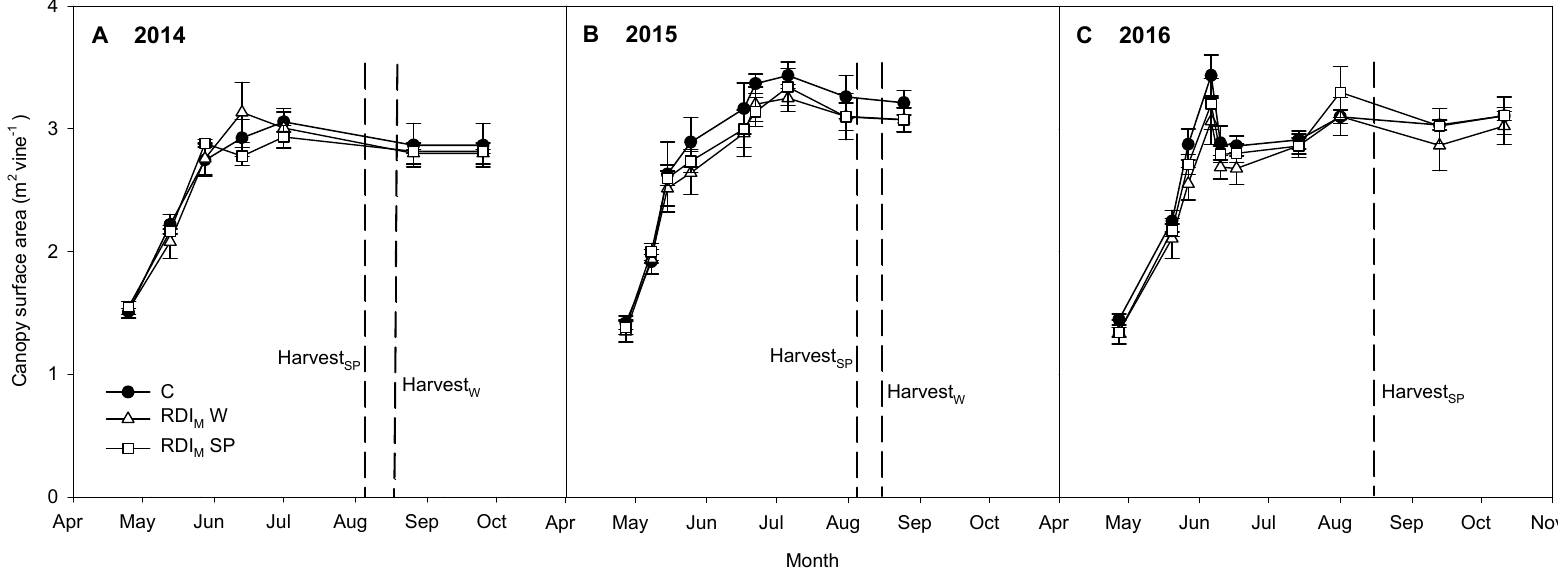
Figure 4. Seasonal variations in canopy surface area for the C, RDI M SP, and RDI M W treatments for 2014 ( A ), 2015 ( B ) and 2016 ( C ). Each value is the mean of four measurements and the bars indicate the standard error of the mean. Harvest SP and Harvest W indicate the harvest time according to sparkling base wine and wine criteria, respectively.